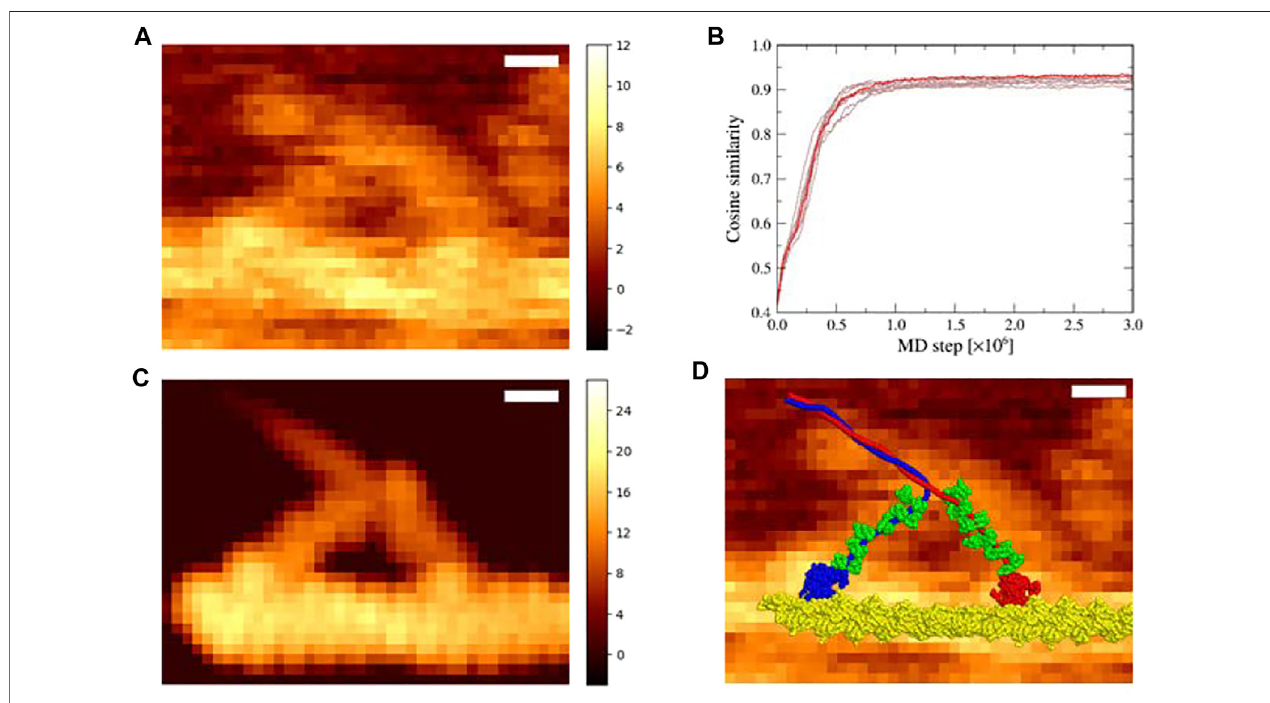
FIGURE 2 | Flexible fi tting simulation of the actin-myosin complex in the down-up state. (A) The corrected experimental AFM image used as a reference in the simulation; scale bar, 10 nm; color bar in nm. (B) Time series of the cosine similarity for ten independent simulation runs are shown in brown. The trajectory involving the largest value is colored in red. (C) The pseudo-AFM image with the highest cosine similarity created using afmize (Niina et al., 2020a; Niina et al., 2020b); scale bar, 10 nm; color bar in nm. (D) The structure model of actin-myosin complex with the highest cosine similarity on top of the reference AFM image; scale bar, 10